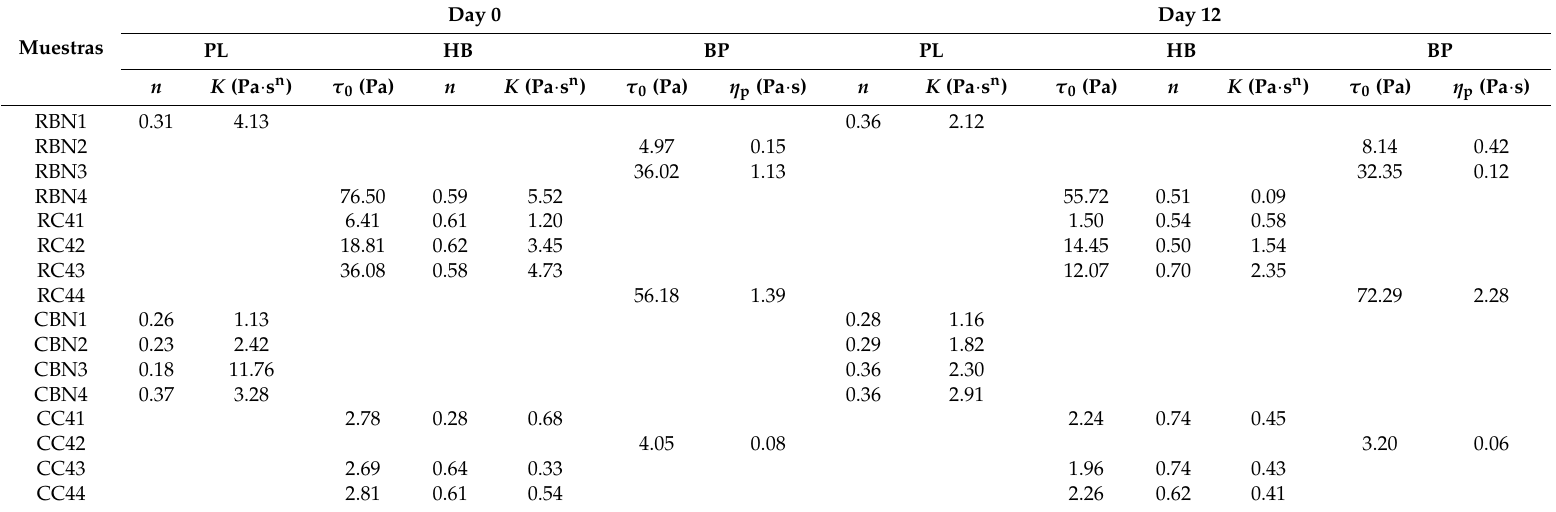
Table 4. Rheological parameters for dairy dessert systems from the best fittings to three flow